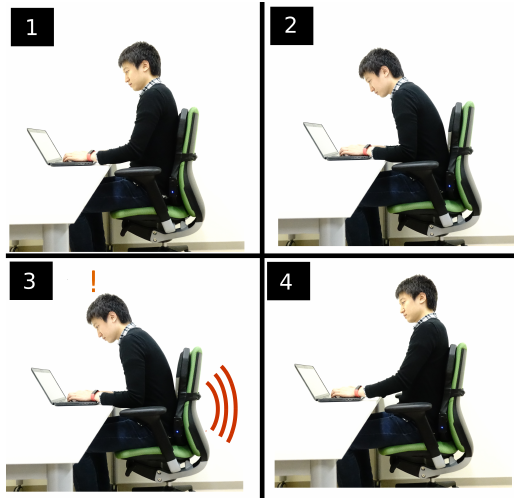
Figure 5. LifeChair system feedback loop: ( 1 ) Sensing sitting posture, ( 2 ) detecting slouching based on posture model, ( 3 ) sending vibrotactile feedback to the user to notify them of slouching, ( 4 ) user corrects their posture and vibration stops.